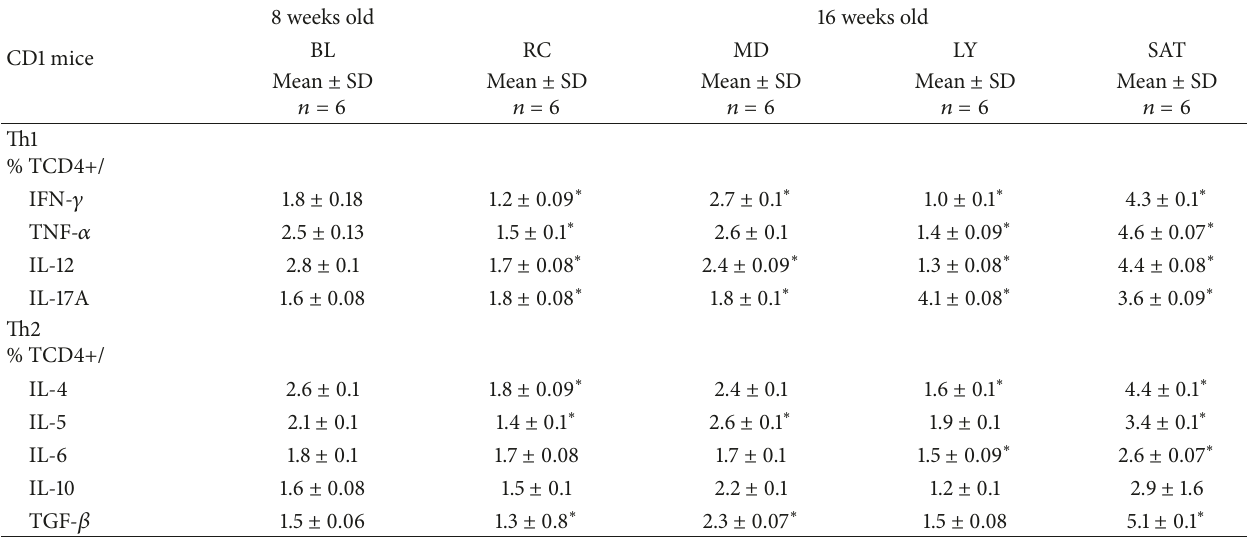
Table 5: Effect of supplementation with EPA and DHA fatty acids extracted from microalgae on Th1 and Th2 cytokines in CD1.